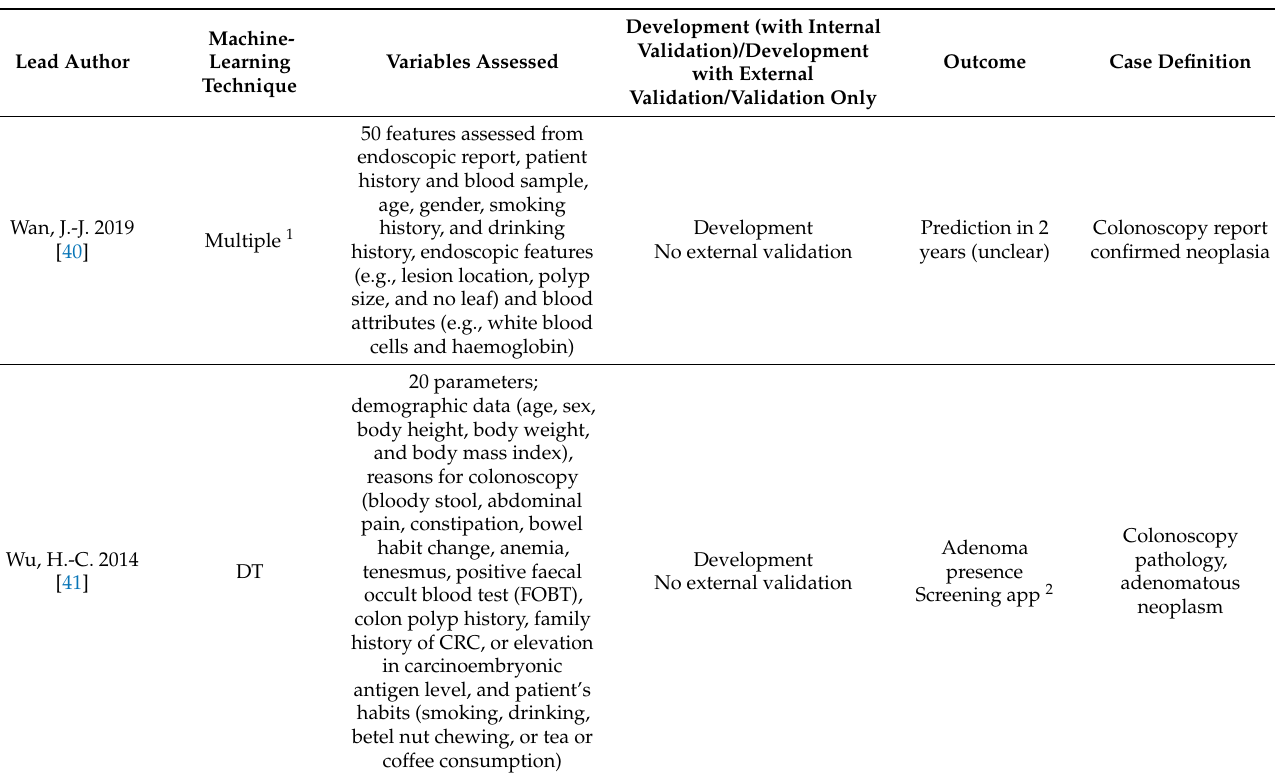
Table 1. Summary of basic model